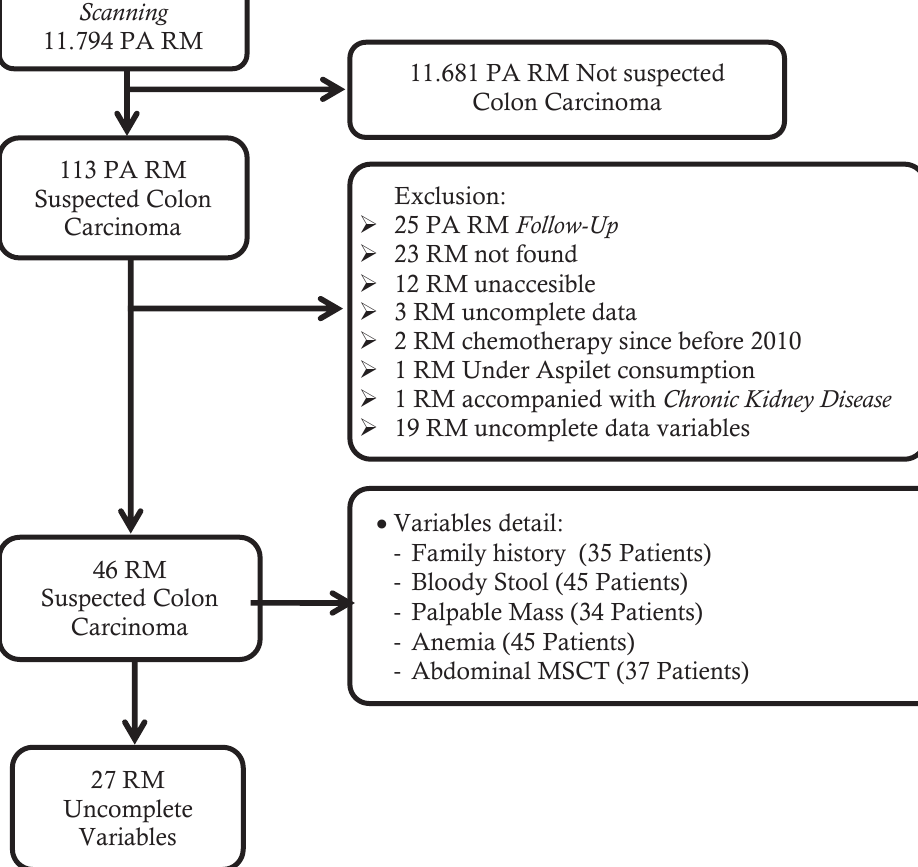
Figure 1. Consort of Research Results